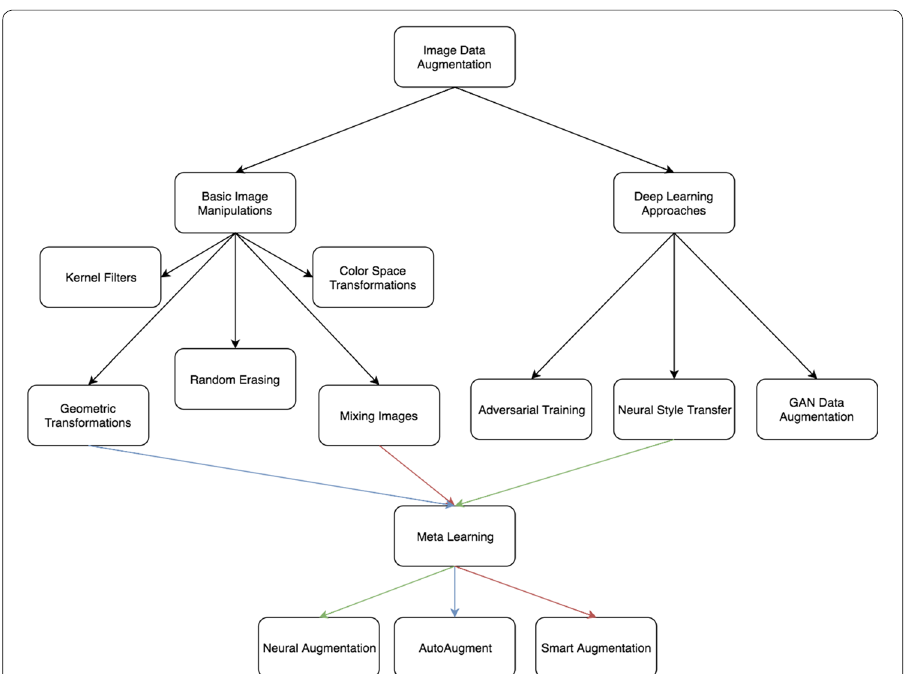
Fig. 2 A taxonomy of image data augmentations covered; the colored lines in the figure depict which data augmentation method the corresponding meta-learning scheme uses, for example, meta-learning